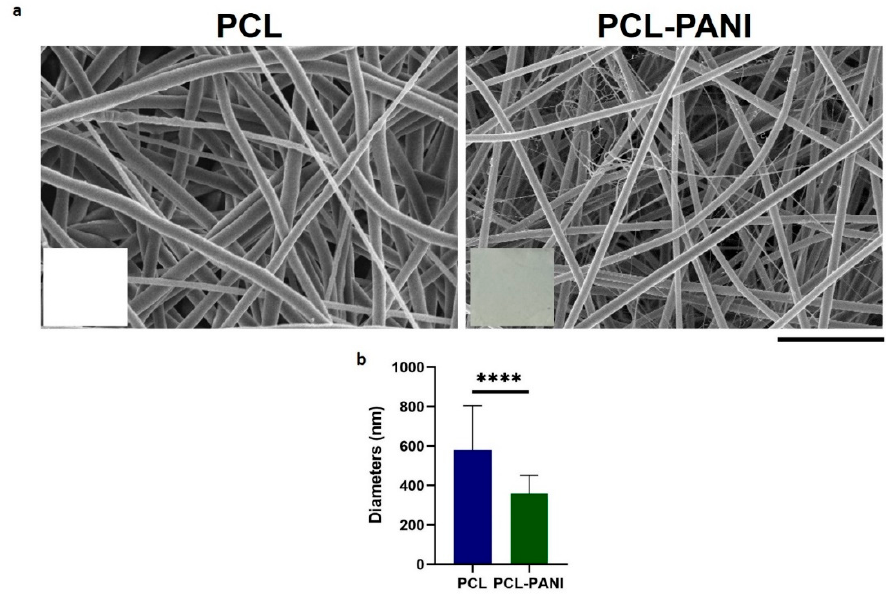
Figure 2. ( a ) FESEM images of optimized PCL and PCL-PANI electrospun membranes (scale bar = 10 µm, magnification = 5 K×). Photograph of PCL and PCL-PANI membranes are reported in the inset; ( b ) Comparison between PCL and PCL-PANI fiber diameters. Statistical difference (**** p < 0.0001).